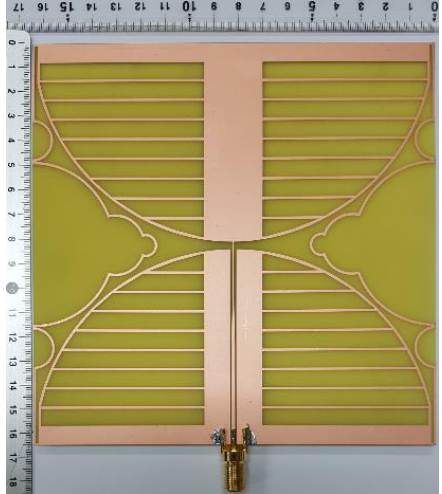
Figure 9. Surface current distributions of the proposed antenna at ( a ) 470 MHz, ( b ) 700 MHz.